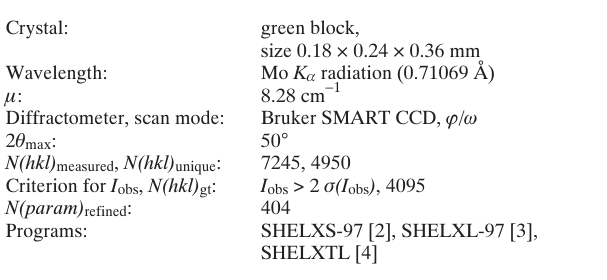
Table 1. Data collection and